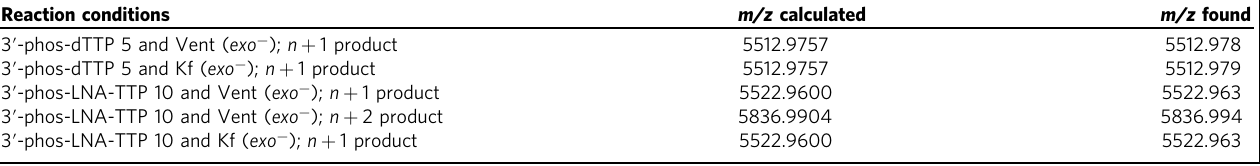
Table 2 Summary of the results from the LCMS analysis of the PEX reaction products obtained on the P1/T3 system and with modi fi ed nucleotides. Reaction conditions